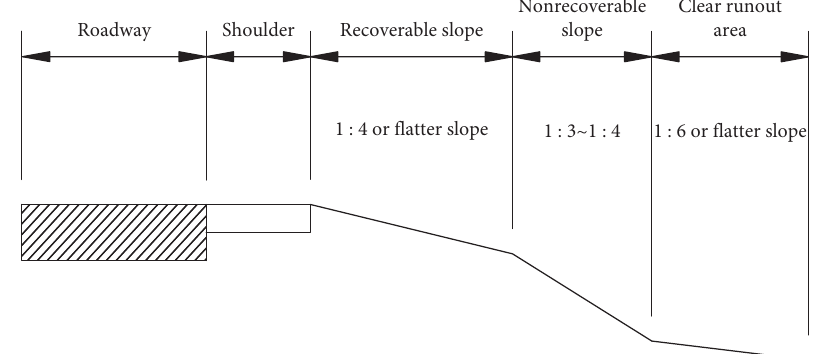
Figure 6: Setting standard of slope in the